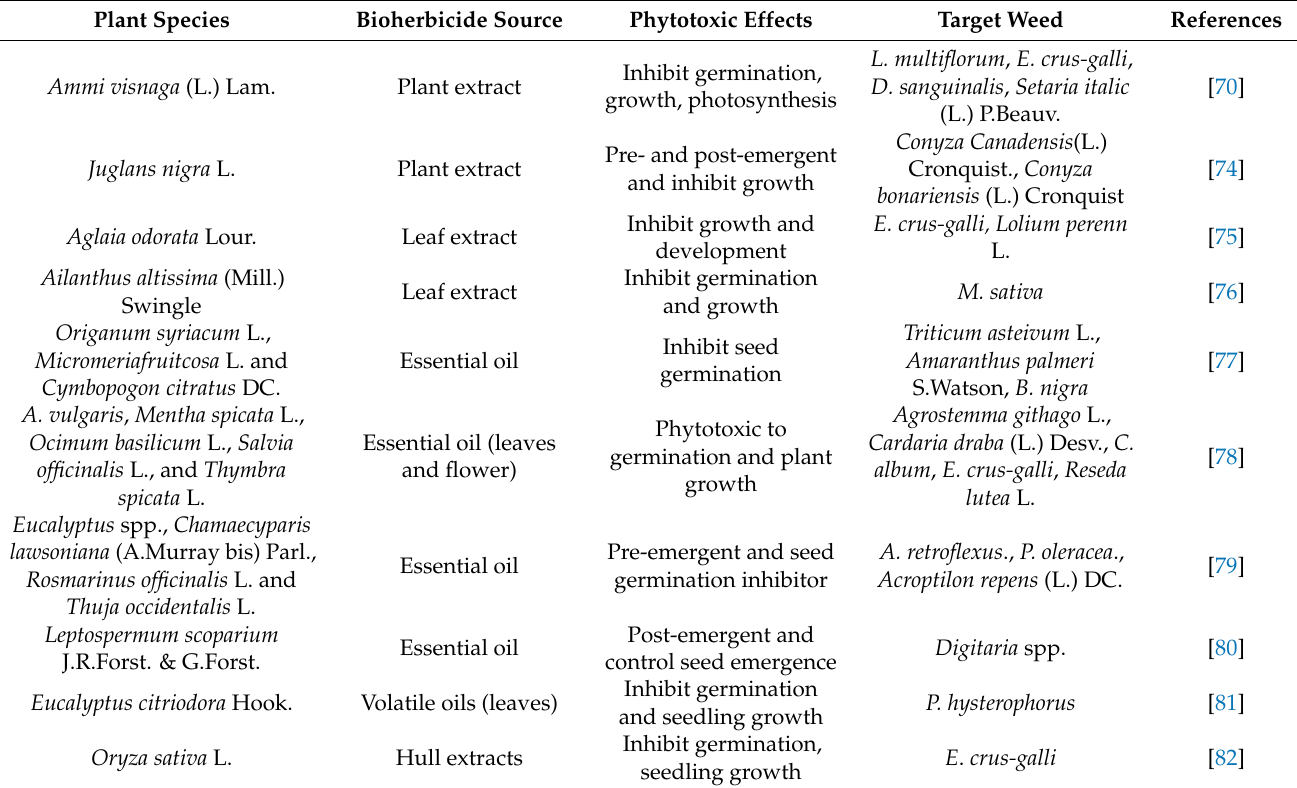
Table 3. Bioherbicides from plant extracts with their respective target weeds and modes of action. Plant